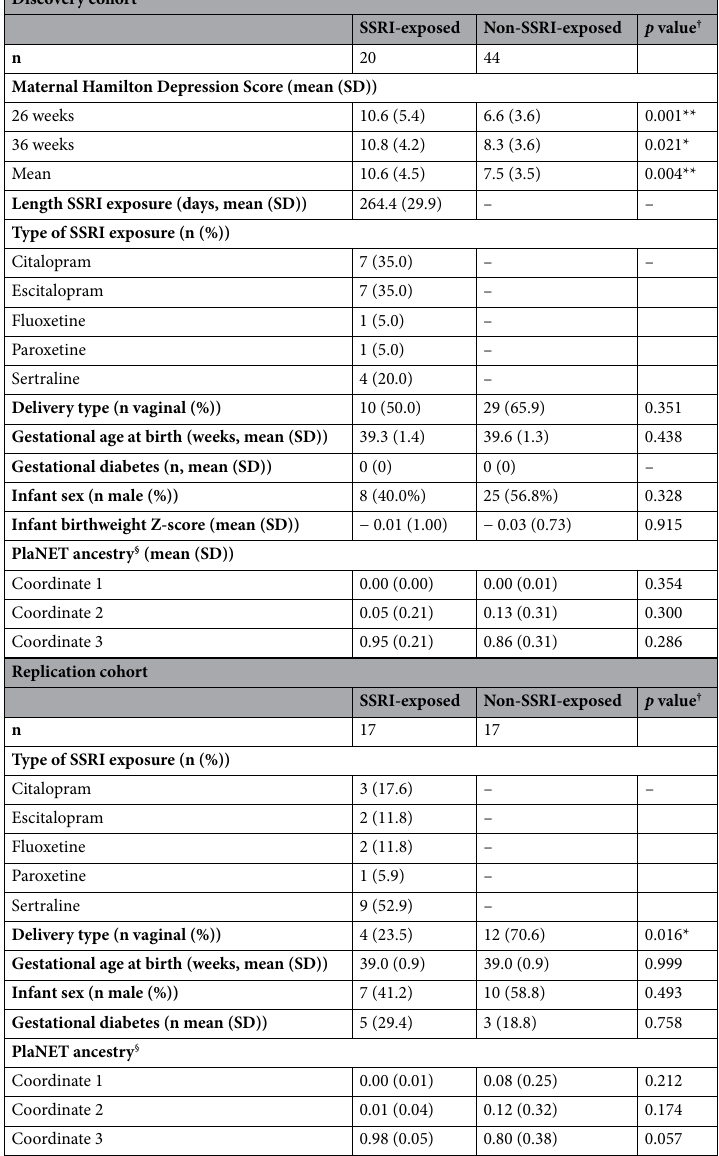
Table 1. Demographics of the discovery and replication cohorts by SSRI exposure status. SSRI refers to selective-serotonin reuptake inhibitor treatment during pregnancy. Birthweight Z-scores were calculated using gestational-age and sex-adjusted birthweight curves 45 . † p values are from chi-squared tests for categorical variables and t-tests for continuous variables, comparing SSRI-exposed to SSRI non-exposed, * indicates < 0.05, ** indicates < 0.005. § The PlaNET algorithm outputs DNAme-based ancestry probability values ranging from 0 to 1, which sum to 1 for each sample. Coordinate 1 is associated with probability of African ancestry, coordinate 2 with East Asian ancestry, and coordinate 3 with European ancestry 46